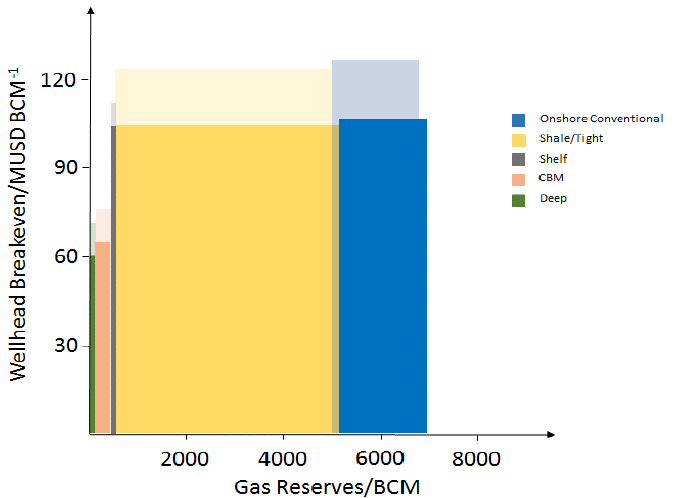
Figure 11. Wellhead breakeven price as a function of cumulative 2P reserves held in producing fields in the US. For clarity, the breakeven is volume-weighted over all asset classes belonging to a given field environment. The business-as-usual scenario (full drilling costs) is shown in light shades and a CD50 scenario (representing a 50% reduction in drilling costs) is shown in dark shades. The CD50 scenario shows a reduction in breakeven prices across all field environments (the darker blocks are lower than the light blocks), as well as reserve additions in shale/tight and CBM field environments (the supply curve of darker blocks is shifted to the right).